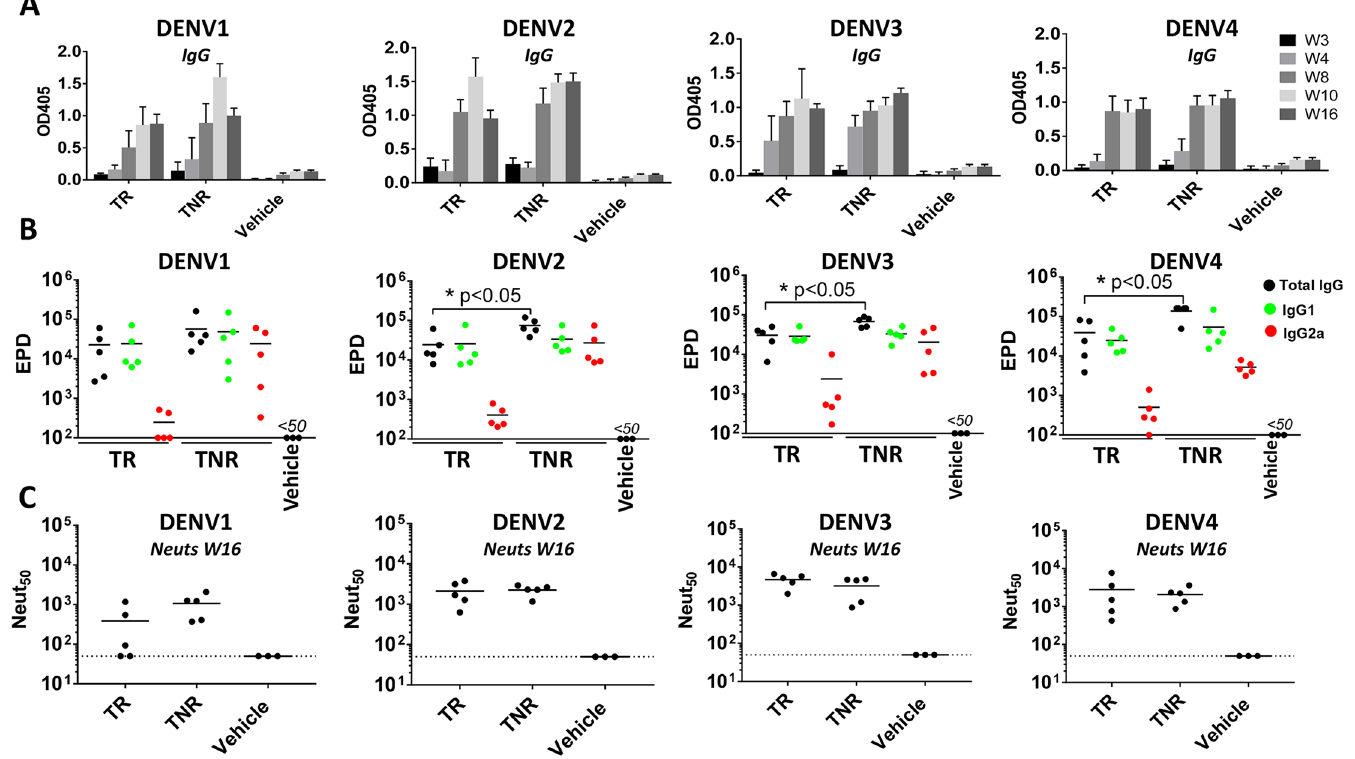
Fig 5. Tetravalent NP-rE immunization induces robust neutralizing IgG responses. A) DENV1-4 specific IgG responses were determined for week 3, 4, 8, 10 and 16. B) DENV1-4 specific IgG end-point dilution titers (EPD) for total IgG, IgG1 and IgG2a were determined for week 16 sera. C) The neutralizing activity of the mice sera at week 16 was determined with a neutralization assay where DENV is incubated with serially diluted mice sera and subsequently allowed to infect Vero-cells. Neutralizing activity was expressed as the dilution where 50% of the virus was neutralized (Neut 50 ). Statistical differences were determined by one-way ANOVA followed by Tukeys test (p <